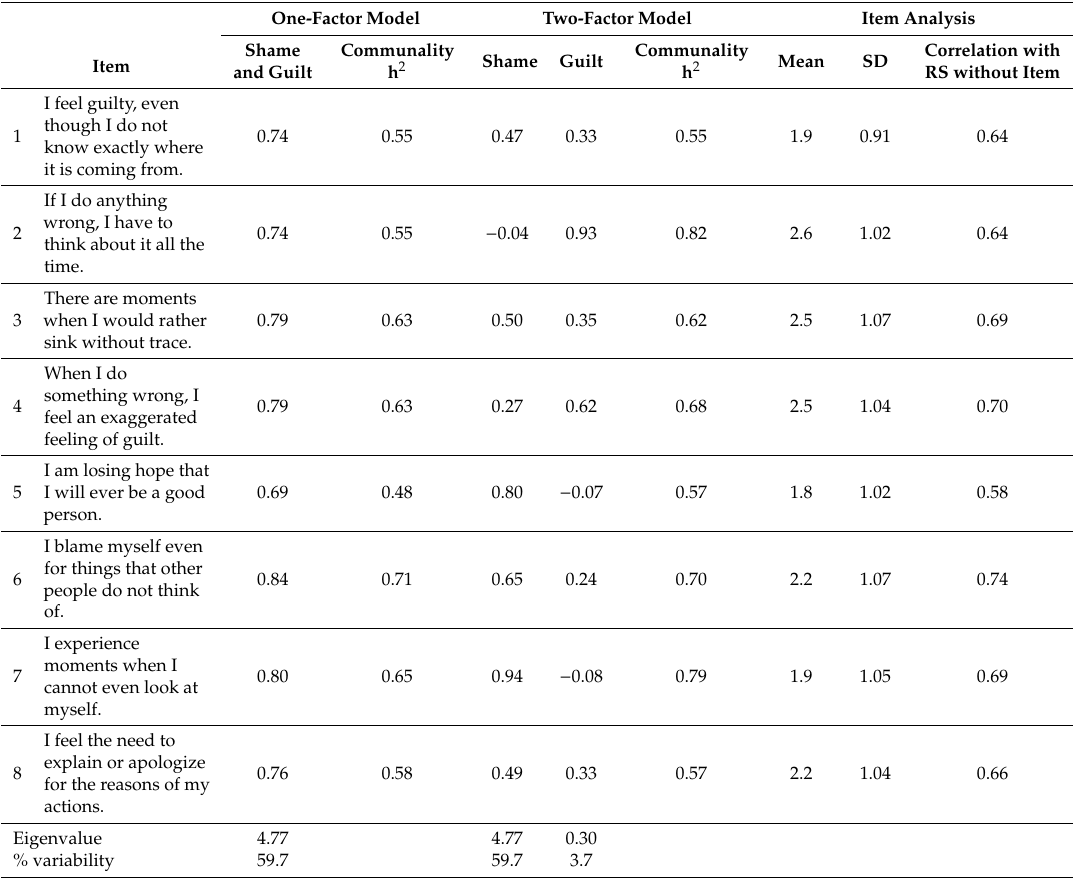
Table 4. Item analysis and factor structure of the GSES scale using exploratory factor